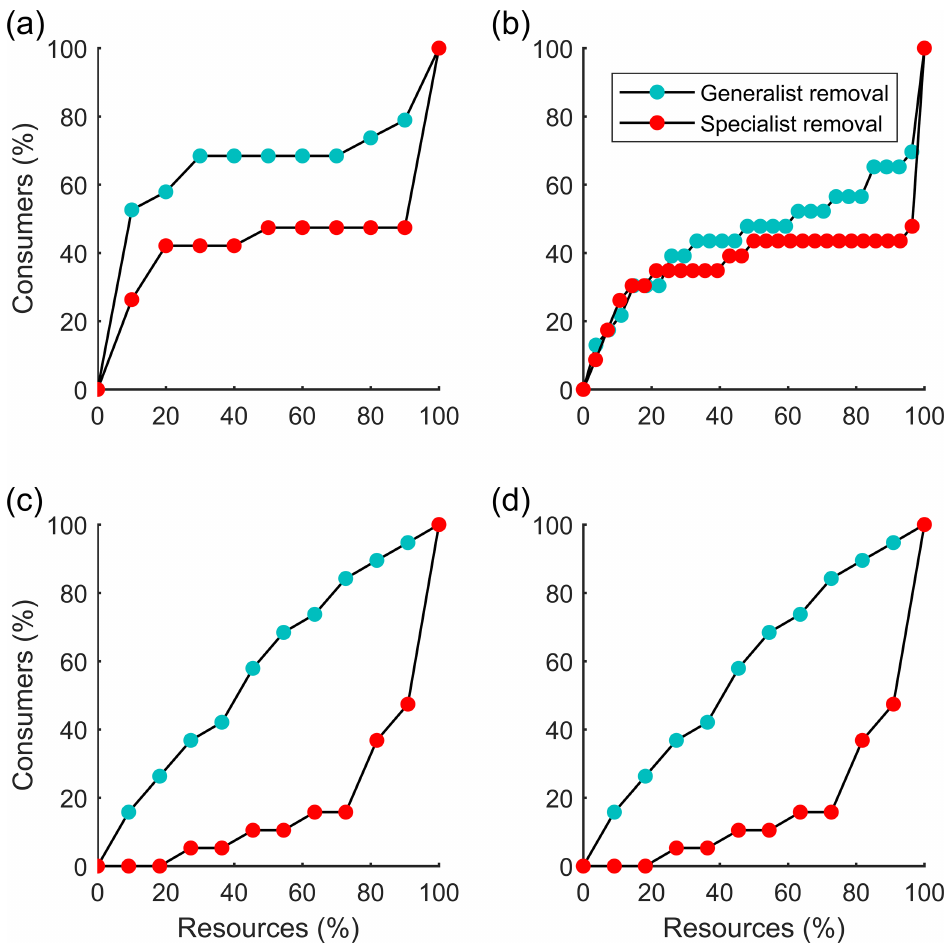
Fig 4. Robustness to the removal of generalists and specialists in two networks (N41 and N43 in S1 Table). Points show the percentageof consumer extinctions that result from the removalof a certain percentage of resource generalists and specialists. Panels (a) and (b) correspondto adaptivenetworks while (c) and (d) correspond to rigid networks.